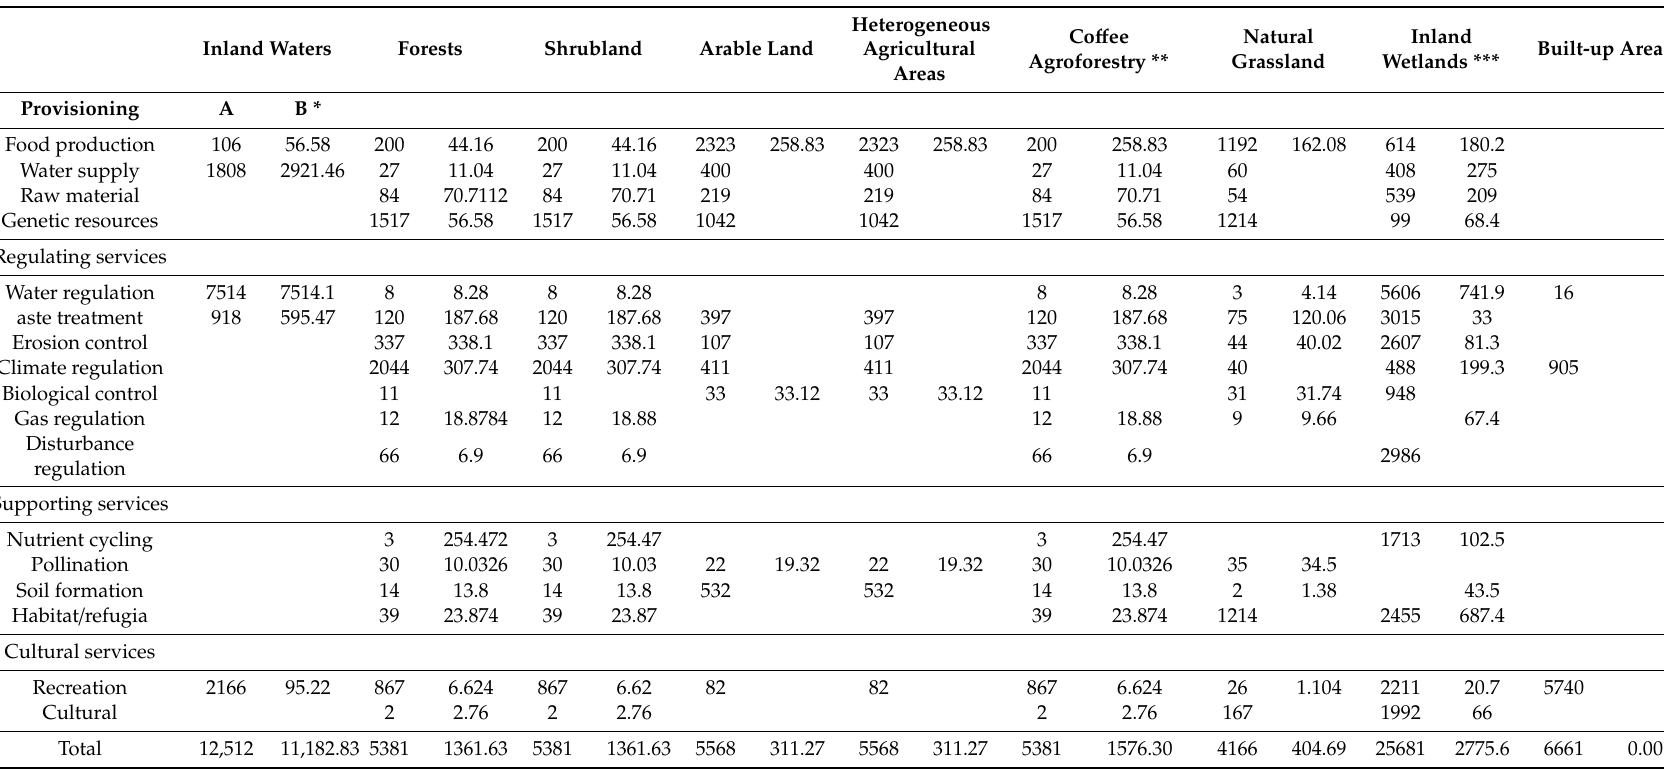
Table 2. Costanza et al. [12] (A) and Kindu et al. [21] (B) ESV coe ffi cients (2007 USD ha − 1 year − 1 ) of the equivalent biomes for the LULC categories in